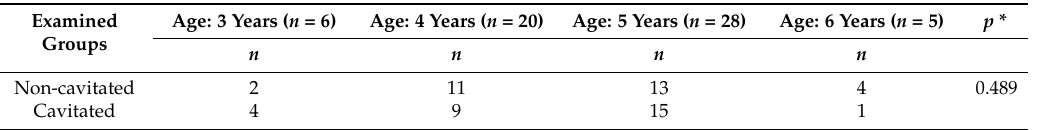
Table 1. Division of study groups according to patient age.